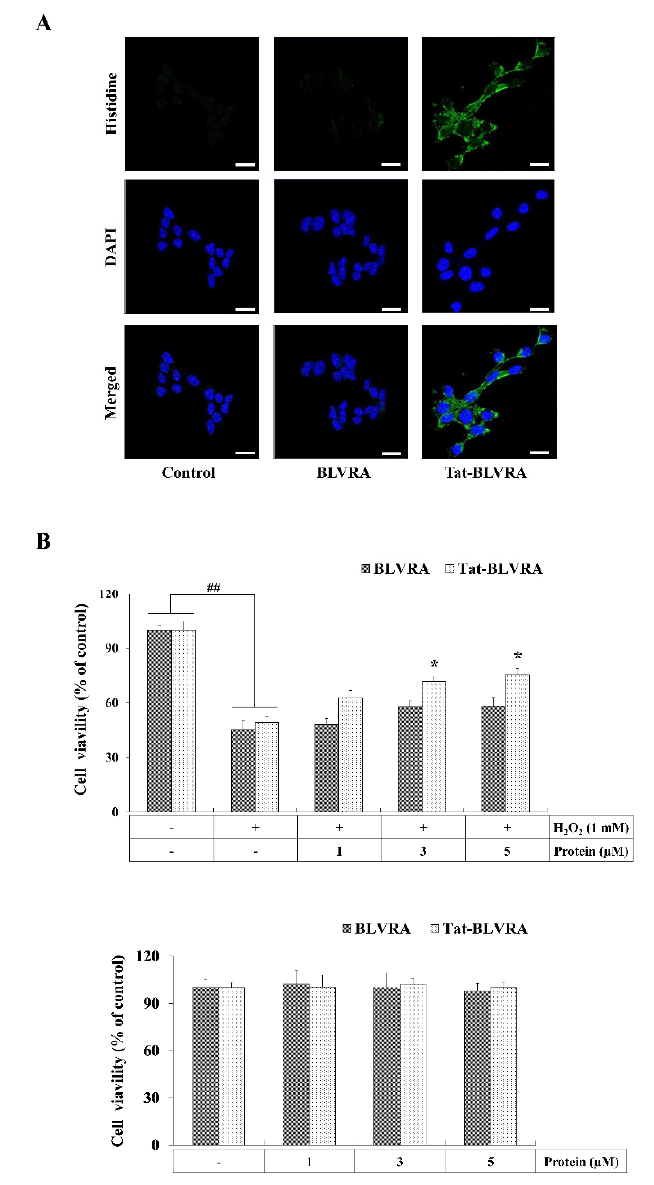
Figure 2. Effect of transduced Tat-BLVRA protein against H 2 O 2 -induced cell death. Cellular distribution of transduced Tat-BLVRA protein in HT-22 cells ( A ). Cells were exposed to Tat-BLVRA and control BLVRA protein (5 µM) for 2 h and the distribution of the transduced Tat-BLVRA protein was observed by confocal microscopy. Scale bar = 50 µm. Cell viabilities were assessed by 3-(4,5-dimethylthiazol-2-yl)-2,5-diphenyl terazolium bromide (MTT) assay ( B ). HT-22 cells were treated with Tat-BLVRA and control BLVRA protein (1–5 µM) for 2 h, after which cells were incubated with or without 1 mM hydrogen peroxide for 2.5 h. The absorbance was measured at 570 nm using an enzyme-linked immunosorbent assay (ELISA) microplate reader and the cell viability was defined as the % of untreated control cells. The bars in the figures represent the mean ± SEM obtained from 3 independent experiments. * p < 0.05 compared to cells treated only with H 2 O 2 . ## p < 0.01 compared to the untreated control cells.